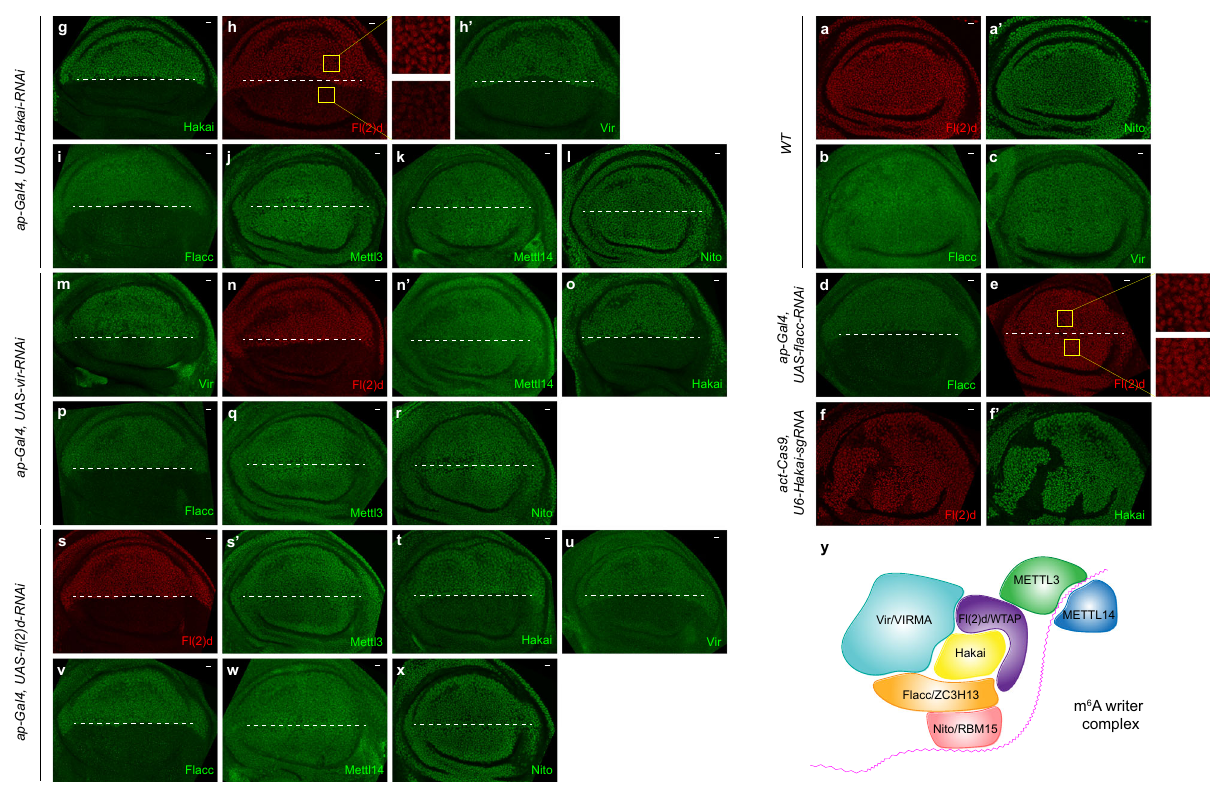
Fig. 4 Hakai, Vir, Fl(2)d, and Flacc form a stable complex. In wild-type wing discs, Fl(2)d ( a ), Nito ( a ’ ), Flacc ( b ), and Vir ( c ) show ubiquitous nuclear staining patterns. g – l Expressing Hakai RNAi in the dorsal half of the disc (below the dashed line) using ap-Gal4 resulted in a strong reduction of Fl(2)d ( h , squared areas are magni fi ed on the right), Vir ( h ’ ), and Flacc ( i ) levels, but not Mettl3 ( j ), Mettl14 ( k ), and Nito staining ( l ). f – f ’ Fl(2)d staining is similarly reduced in Hakai mutant clones generated by actin-Cas9/U6-Hakai-sgRNA ( f ), which are marked by the loss of Hakai staining ( f ’ ). m – r Expressing vir RNAi in the dorsal half of the disc (below the dashed line) using ap-Gal4 resulted in a strong reduction of Fl(2)d ( n ), Hakai ( o ), and Flacc ( p ) levels, but not Mettl3 ( q ), Mettl14 ( n ’ ), and Nito staining ( r ). s – x Expressing fl (2)d RNAi in the dorsal half of the disc (below the dashed line) using ap-Gal4 resulted in a strong reduction of Hakai ( t ), Vir ( u ), and Flacc ( v ) levels, but not Mettl3 ( s ’ ), Mettl14 ( w ), and Nito staining ( x ). d , e Expressing Flacc RNAi in the dorsal half of the disc (below the dashed line) using ap-Gal4 led to more diffusive and less nuclear staining of Fl(2)d ( e , squared areas are magni fi ed on the right). The experiments in a – x were repeated at least twice independently with similar results, and each time around 30 wing discs for any genotype were examined. Scale bars: 10 μ m. y A working model of the m 6 A writer complex comprised of seven core